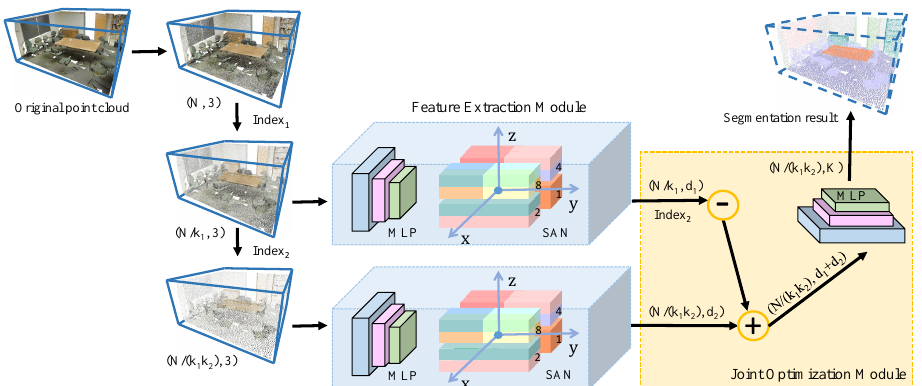
Figure 1. Illustration of the proposed multi-scale feature fusion network (MSSCN). First, downsampling is performed on the original point cloud with sampling proportions of k 1 and k 2 . The chosen points are stored in Index 1 and Index 2 for the first and second downsampling processes, respectively. Then, feature extraction is performed using a Spatial Aggregation Net (SAN) backbone, where d 1 and d 2 are the dimensionalities of the features for each downsampled point cloud. Finally, feature fusion is performed to obtain a relevant set of features, where ‘ − ’ indicates the deletion of descriptors that do not exist in Index 1 according to Index 2 and ‘+’ indicates feature fusion. Based on the extracted features, a multilayer perceptron (MLP) is used to obtain the score of each point for each of the K object